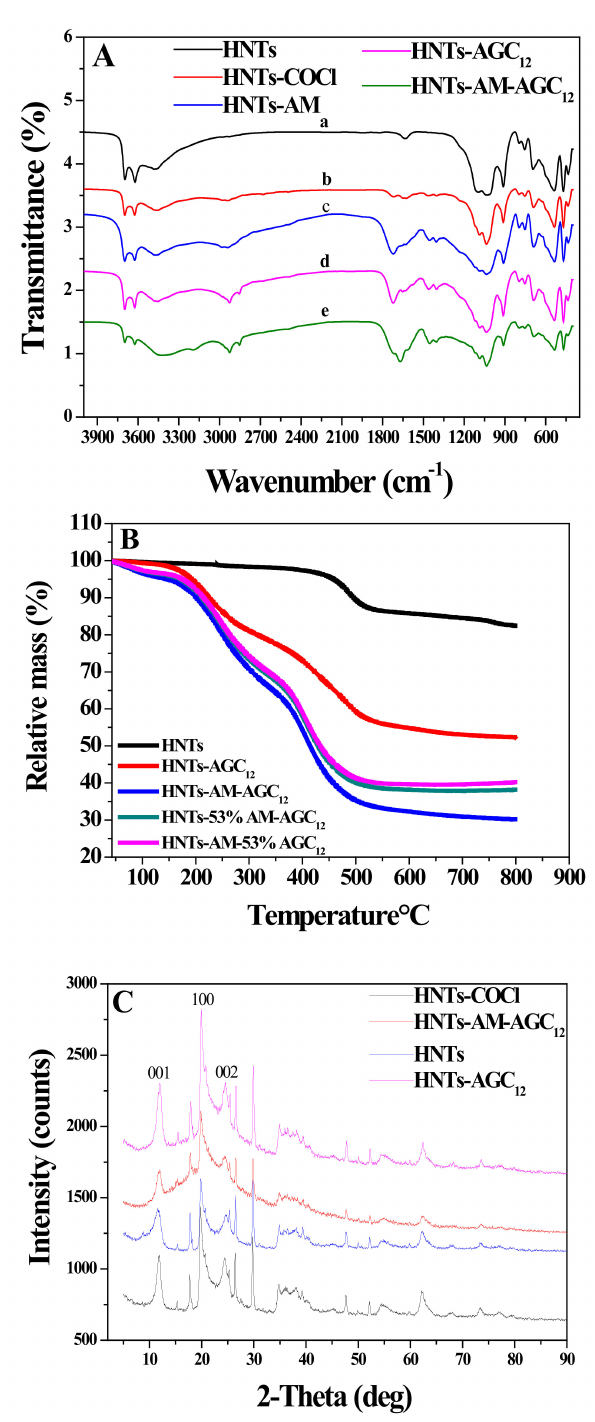
Figure 2. ( A ) FTIR spectra of (a) pristine HNTs, (b) HNTs–COCl, (c) HNTs–AM, (d) HNTs–AGC 12 and (e) HNTs-AM-AGC 12 nanocomposites; ( B ) TGA curves of pristine HNTs (HNTs, 1), HNTs-AGC 12 , HNTs grafted with AGC 12 (2), HNTs grafted with AGC 12 and AM under N 2 (3); ( C ) XRD spectra of halloysite before and after